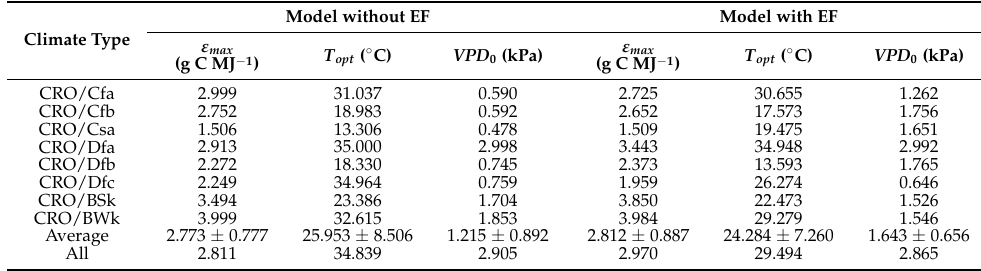
Table 5. Optimized model parameters ( ε max , T opt , and VPD 0 ) of the LUE-based model for crop GPP estimate in different climate zones (‘with EF’ denotes our new EF-LUE model; ‘without EF’ means water availability constraint was not